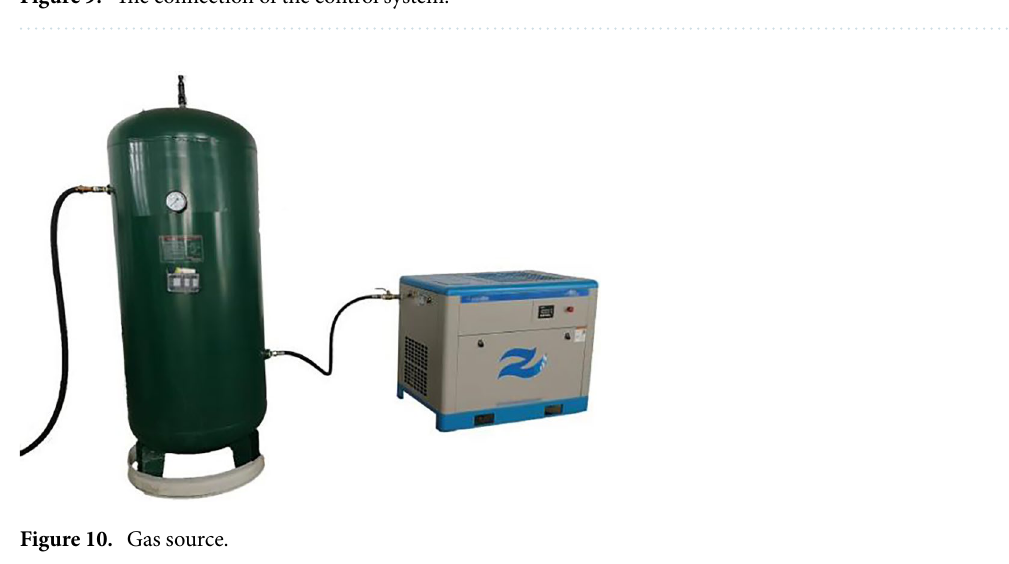
Figure 9. The connection of the control system.